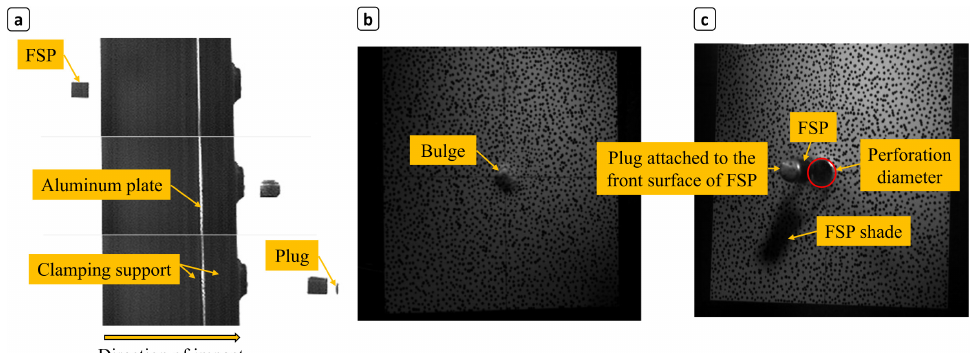
Figure 5. ( a ) Image sequence of the ballistic impact event (configuration 2) captured by high-speed camera 1 at different time steps showing the penetration and the perforation process in the plate: ( b ) bulge created by the FSP at the rear surface of the plate at the moment of impact, ( c ) a plug punched through the plate after full perforation and flying together with the